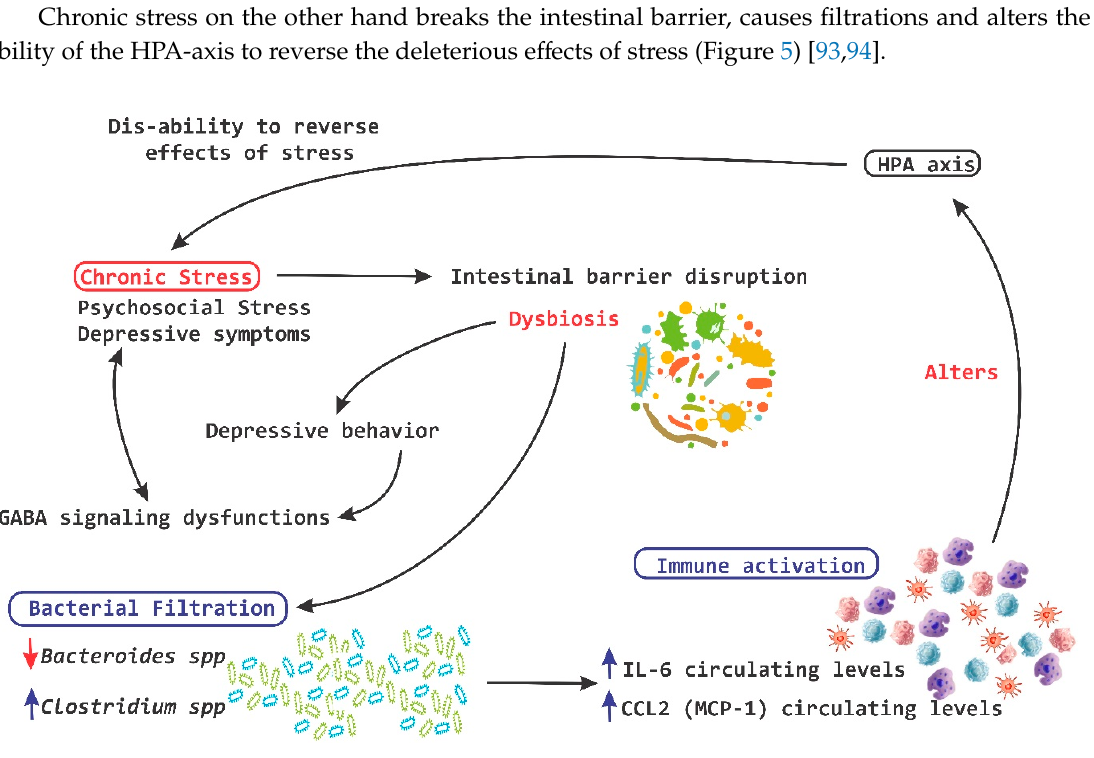
Figure 5. Chronic stress and HPA axis. A chronic stress process is capable of causing disruption at a level of the intestinal barrier and cause dysbiosis, which in turn induces the leakage of bacteria and the activation of the local immune system, leading to a significant alteration of the hypothalamic pituitary adrenal (HPA)-axis. IL, interleukin; MCP-1, monocyte chemoattractant protein; red arrow down mean decrease levels; blue arrow up mean increase levels.